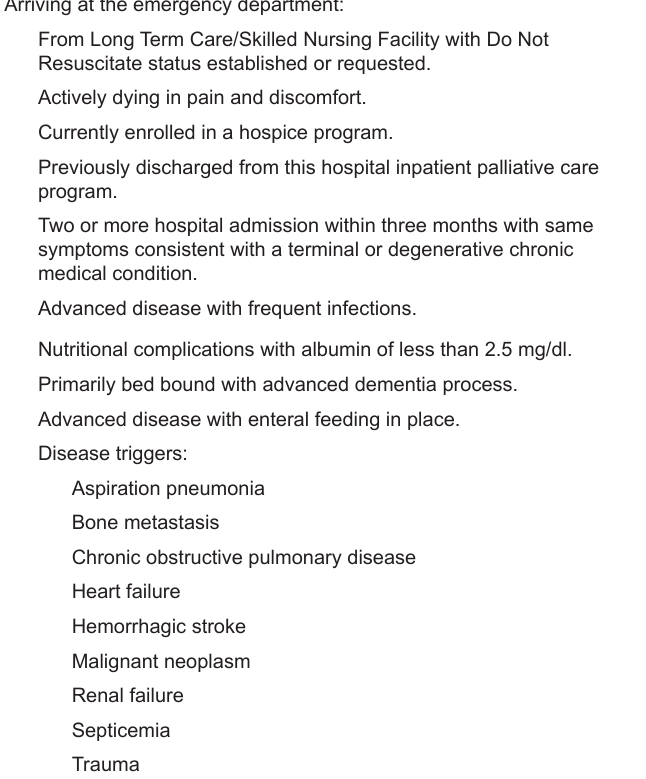
Figure 1. Triggers for emergency department palliative care